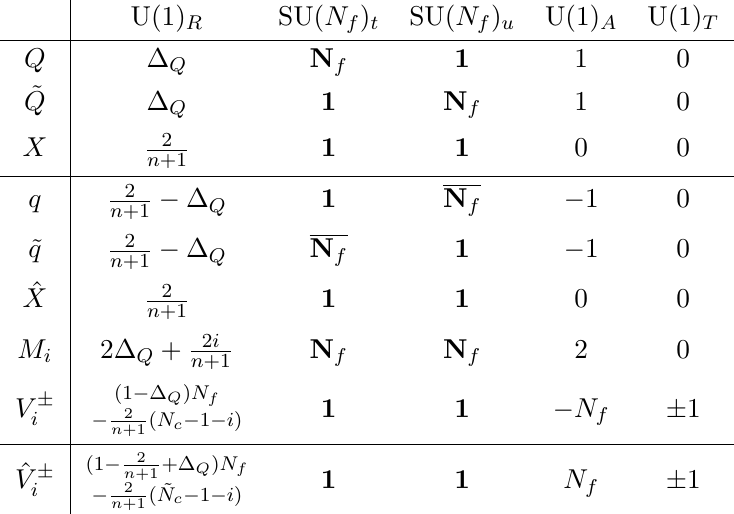
Table 1 . The representations of the chiral operators under the global symmetry groups of the theory with one adjoint and fundamental matters. The elementary fields of Theory A are presented in the top box, whereas those of Theory B are presented in the middle box. Both the monopole operators of Theory A and their dual singlets are denoted by V ± , whose charges are shown in the i middle box. Similarly, the monopole operators of Theory B are denoted by ˆ V ± , whose charges are i shown in the bottom box. Note that ˜ N is the dual gauge rank, which is defined by ˜ N = nN c c f − N c